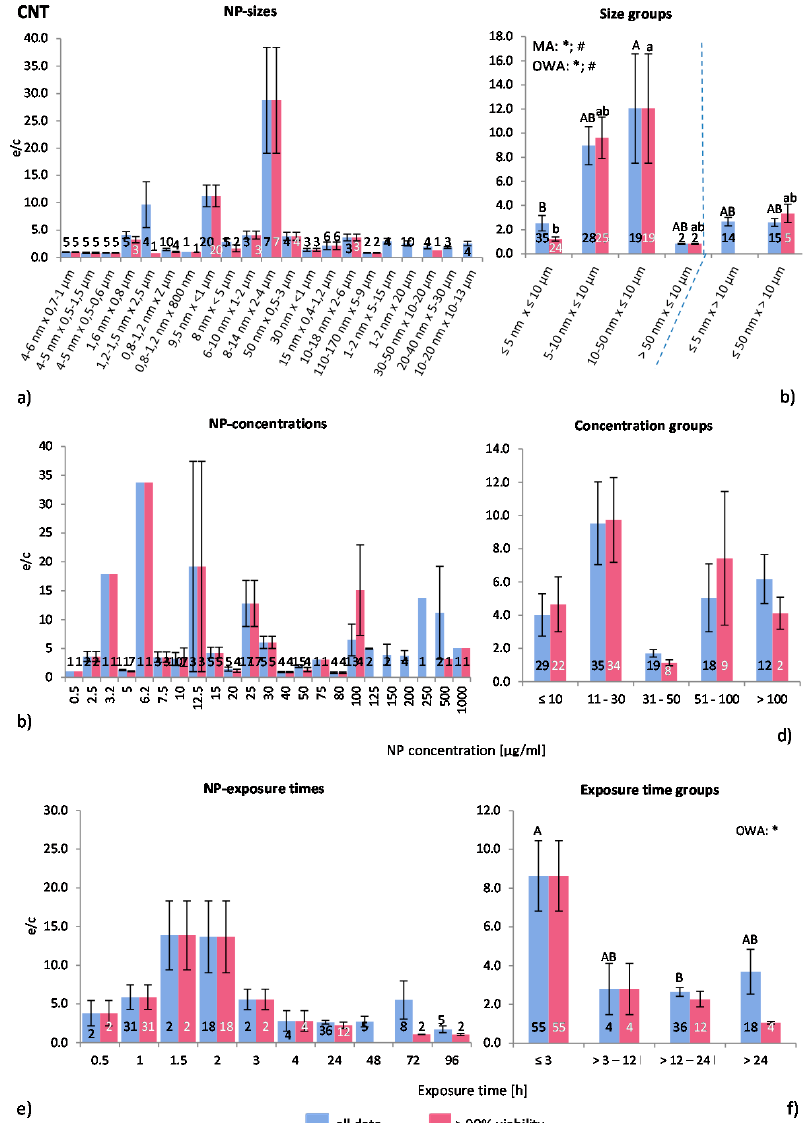
Figure 8. The effect of NP-size, concentration and exposure time on ROS ratios after exposure to CNT-NP. Data are illustrated as mean ± SEM and numbers inside the bars represent the number of investigations. Mean ROS ratios as a function of ( a ) NP-size, ( c ) NP-concentration and ( e ) exposure times are shown. Multiple Regression Analysis (MRA) was used to identify correlations between the independent variables NP size, concentration or exposure time and the dependent variable ROS ratio; ( b , d , f ) show the respective groupings that were analyzed with multi-factor ANOVA (MA) for statistical significant inhomogeneity for three variables, one-way ANOVA (OWA) for one variable, and the modified post-hoc Tukey test for unequal n for group differences. The bars labelled “a” or “A” etc. are statistically different from “b” or “B” but not from “ab” or” AB”. p < 0.05 for * all data and # for >90% viability.